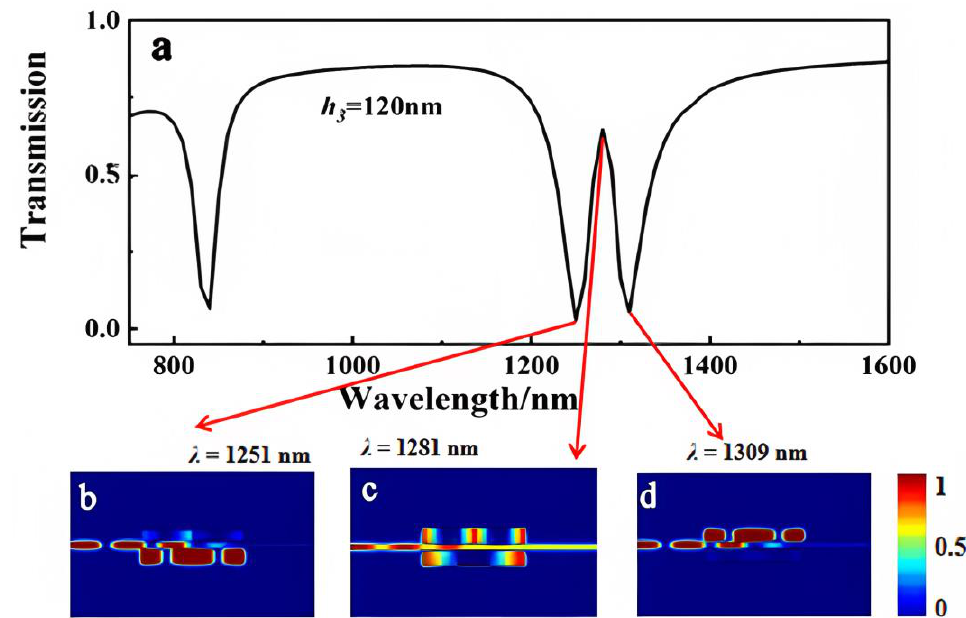
Figure 5. ( a ) Transmission spectrum of the MIM waveguide with the three-rectangle resonators shown in Figure 1 when h 3 = 120 nm. The field distribution | Hz | 2 of the structure at the incident wavelengths of ( b ) 1251 nm, ( c ) 1281 nm, and ( d ) 1309 nm.